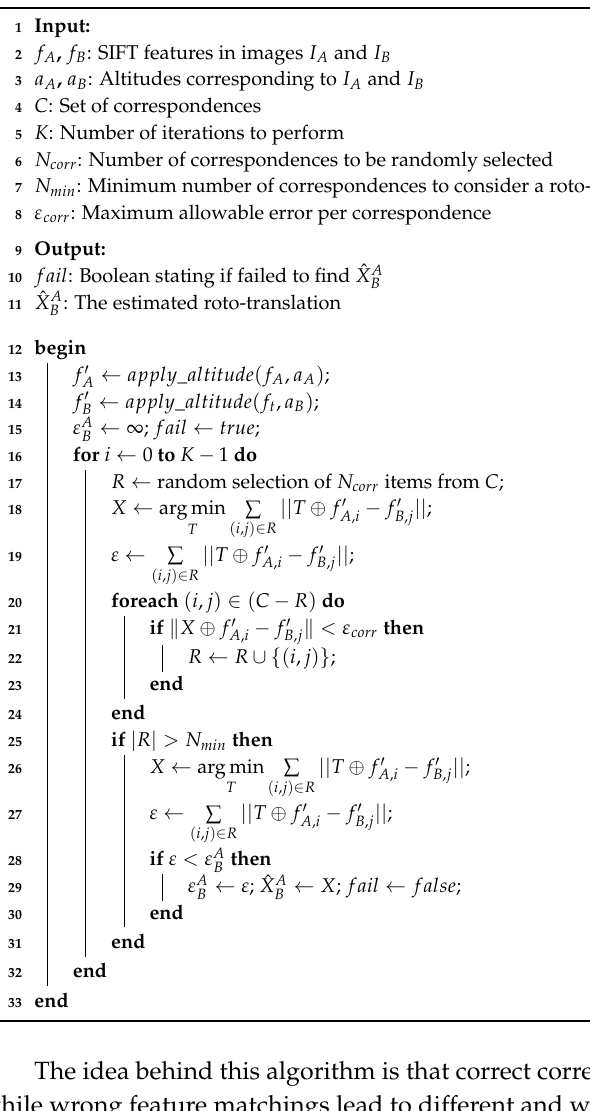
Algorithm 1: RANSAC approach to estimate the motion ˆ X A